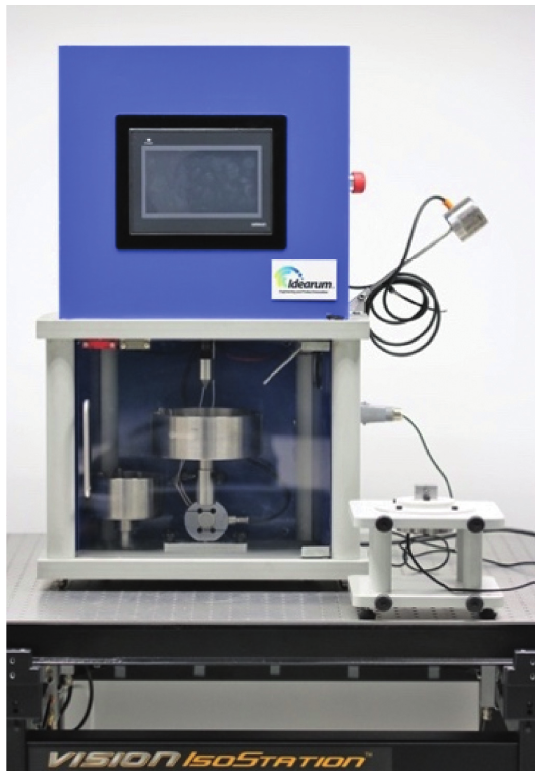
Figure 4: CS-Dental Testing Machine ® (Barcelona,